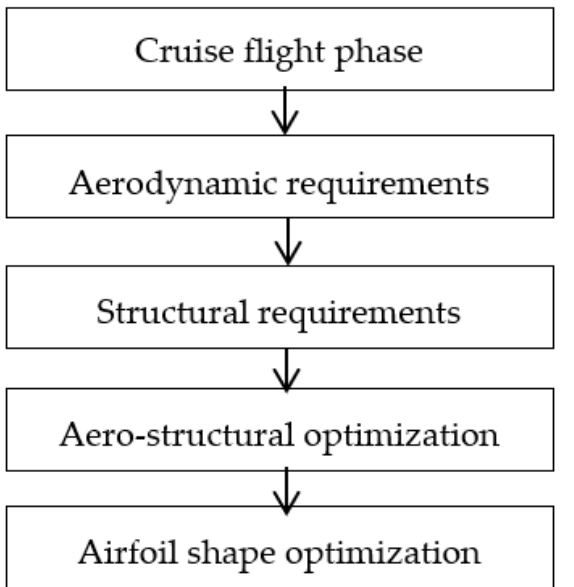
Figure 7. The adaptive wing multidisciplinary optimization methodology.